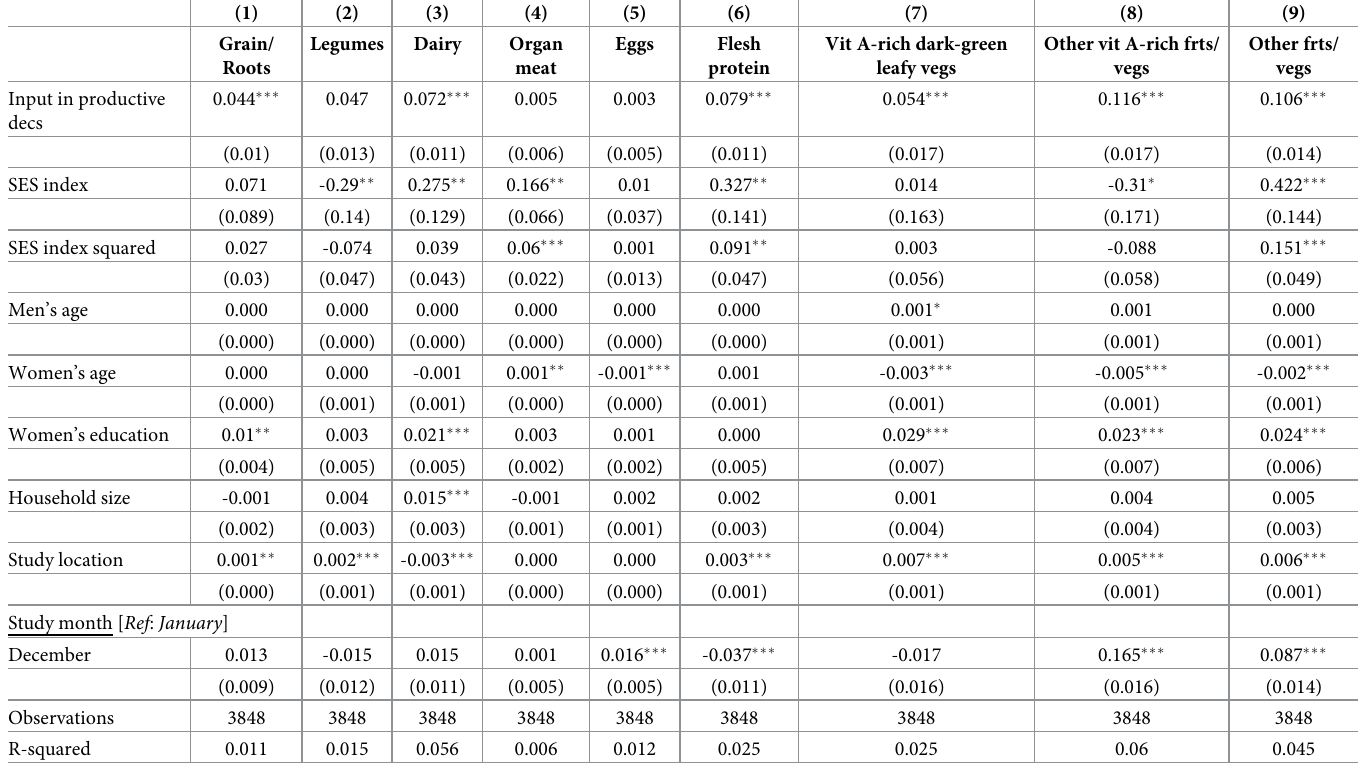
Table 18. LPM regression for food groups consumed–production domain (Input in � 2 productive